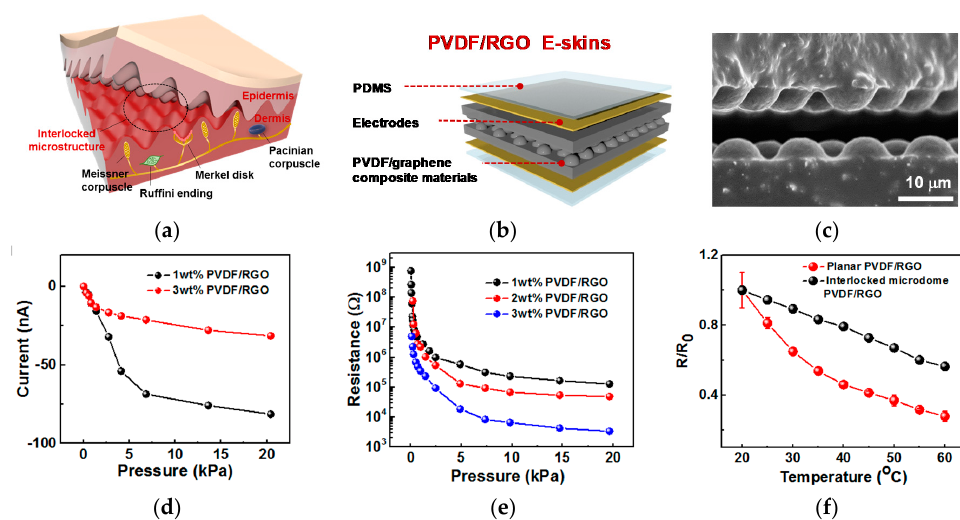
Figure 2. Design concept and electrical characteristic of PVDF/RGO e-skin device: ( a ) structure of fingertip skin; ( b ) bio-inspired e-skin device from fingertip skin; ( c ) micrograph of e-skin device; ( d ) piezoelectric characteristic; ( e ) piezoresistive characteristic; and ( f ) pyroresistive characteristic.